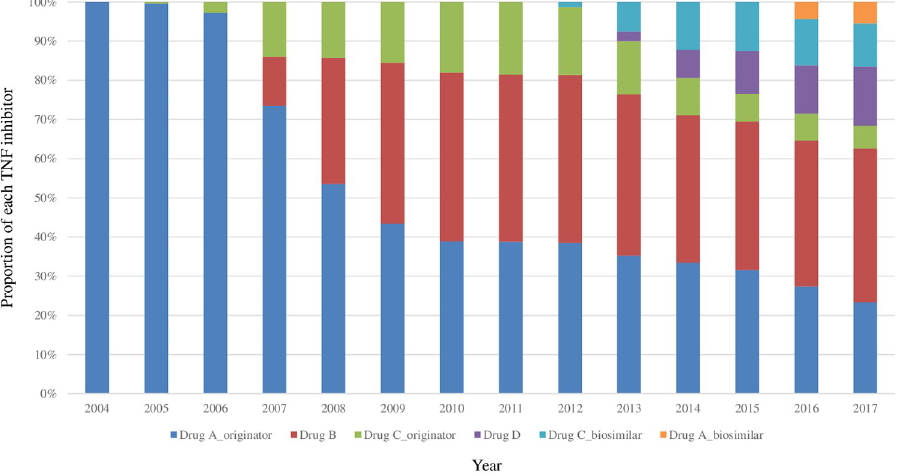
Fig 1. Use of each TNF inhibitor in patients with RA or AS since the approval of TNF inhibitors: Proportions of each TNF inhibitor used by patients with RA or AS since the approval of TNF